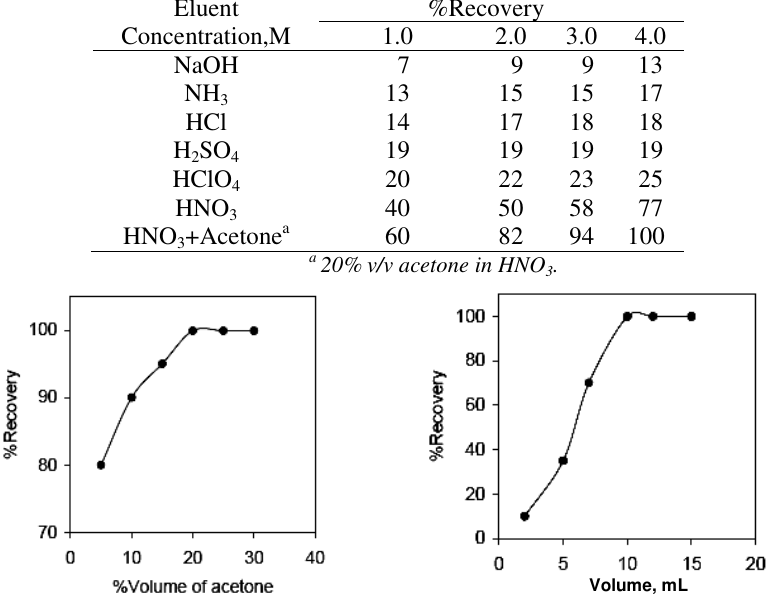
Figure 4 . Effect of %volume of acetone in the eluent Figure 5 . Effect of volume of